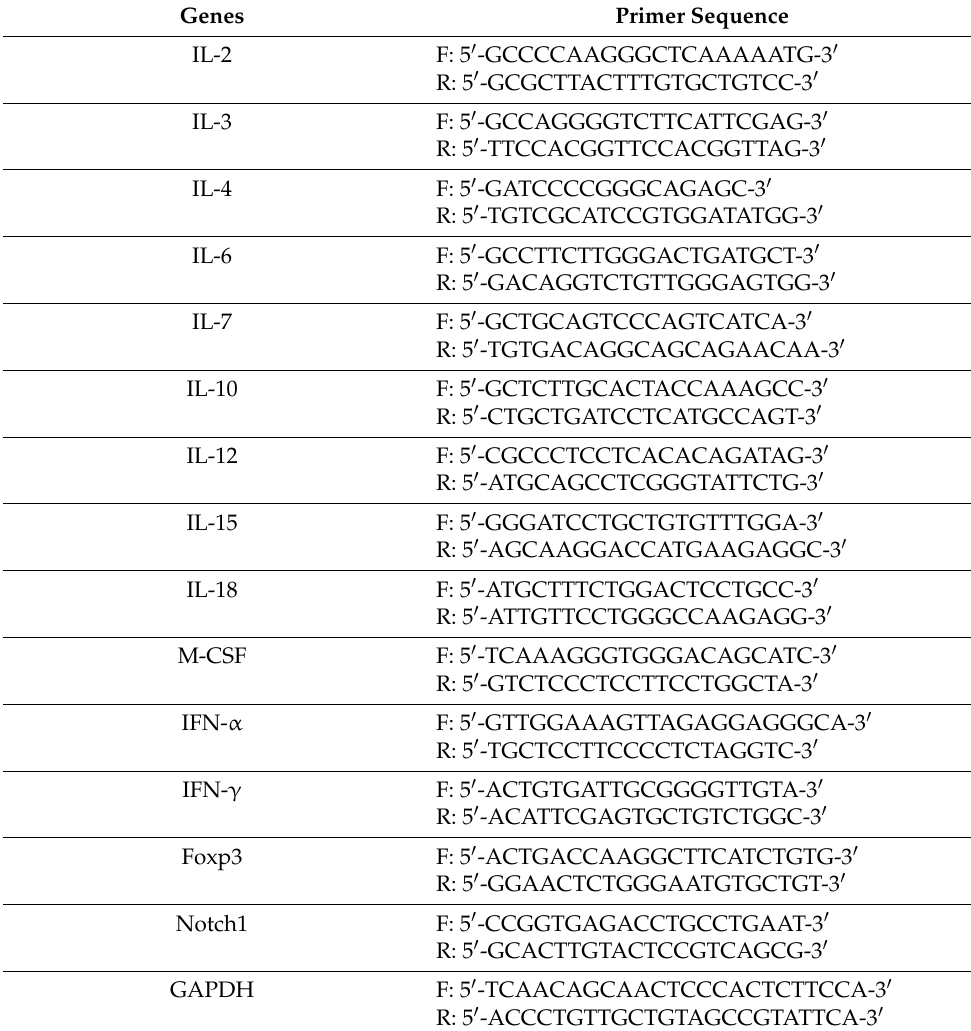
Table 1. Primers sets used for the